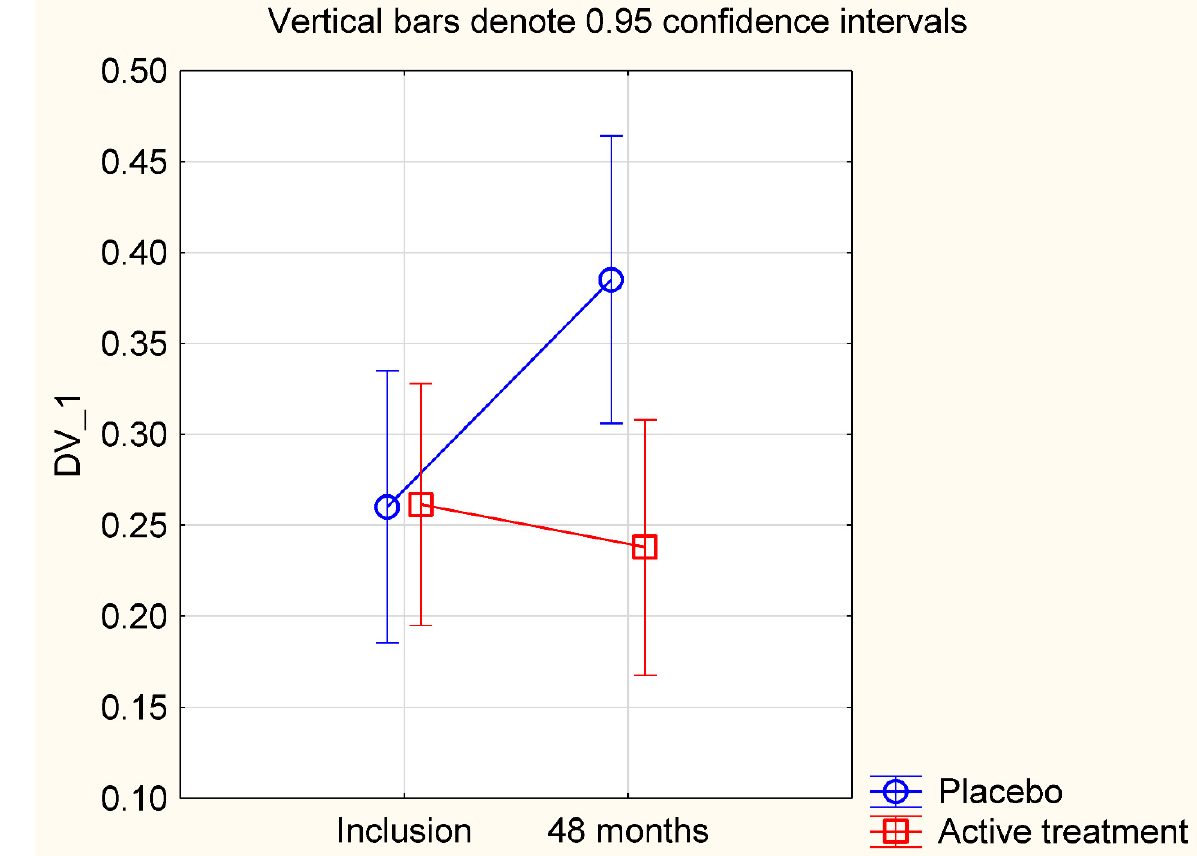
Figure 3. Concentration of D-dimer at the start of the project and after 48 months in the selenium and coenzyme Q 10 treatment group compared to the placebo group in a sub-group of the study population consisting of participants with hypertension or ischaemic heart disease. Evaluation performed by use of repeated measures of variance methodology. Current effect: (F(1,75) = 6.23; p = 0.015). Vertical bars denote 0.95 confidence intervals. Blue curve: Placebo; Red curve: Active treatment group. Bars indicate ±95% CI.